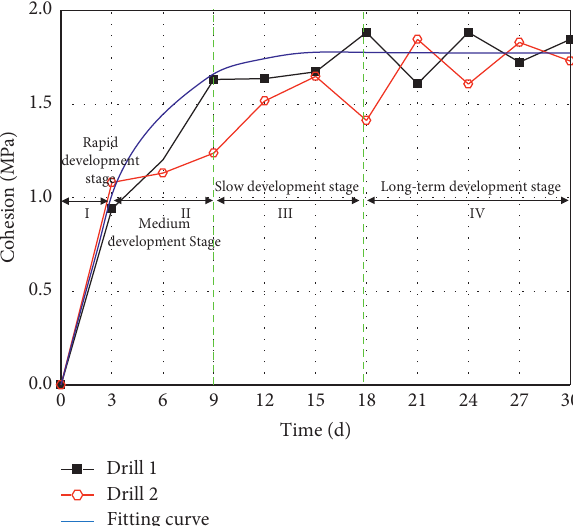
Figure 15: Development of cohesion with the underground curing